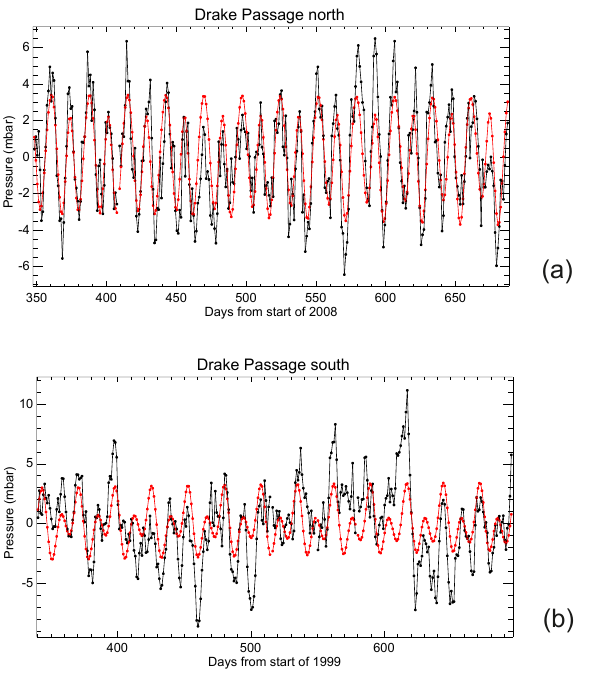
Figure 4. (a) An example of a fit (red) to daily mean BP values from the north side of the Drake Passage (black) in terms of three harmonics with the frequencies of Mf, Mm and Mt during a period when the amplitude of Mf was larger than average. (b) An example of a record from the south side of the Drake Passage during a pe- riod when the amplitude of Mf was smaller than average and so the contribution of Mm is more